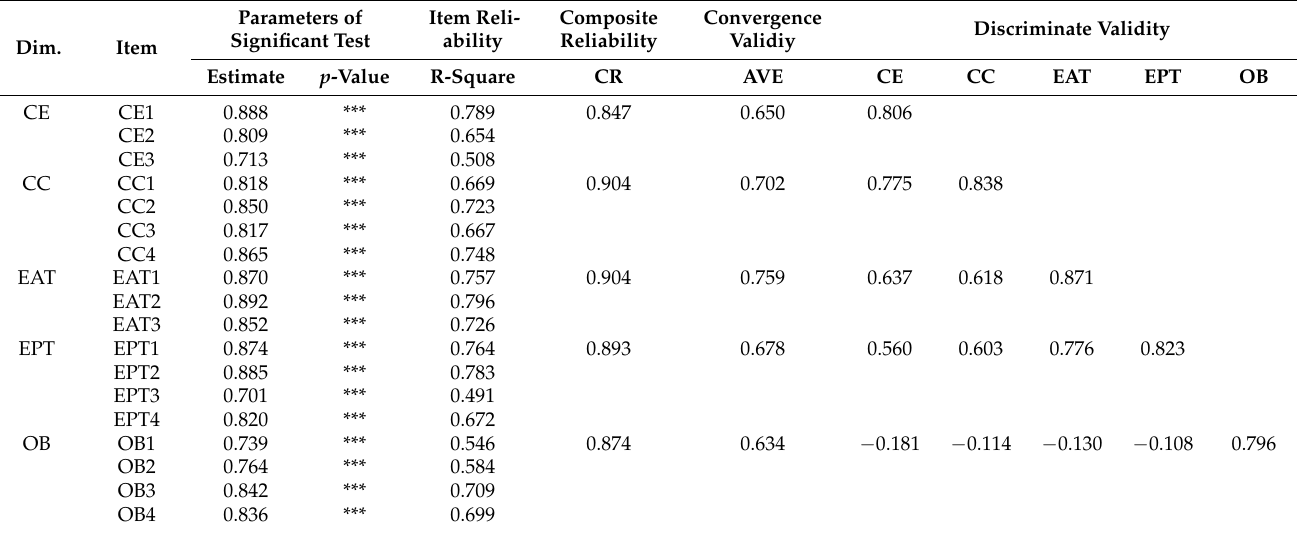
Table 3. Convergence validity and Reliability Analysis